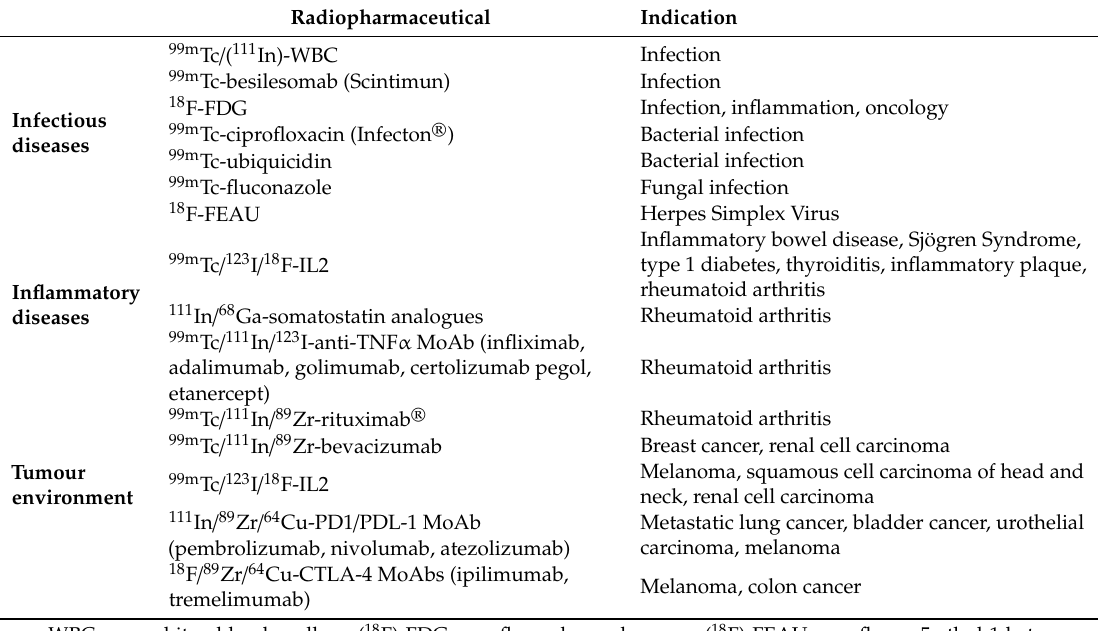
Table 1. Overview of discussed